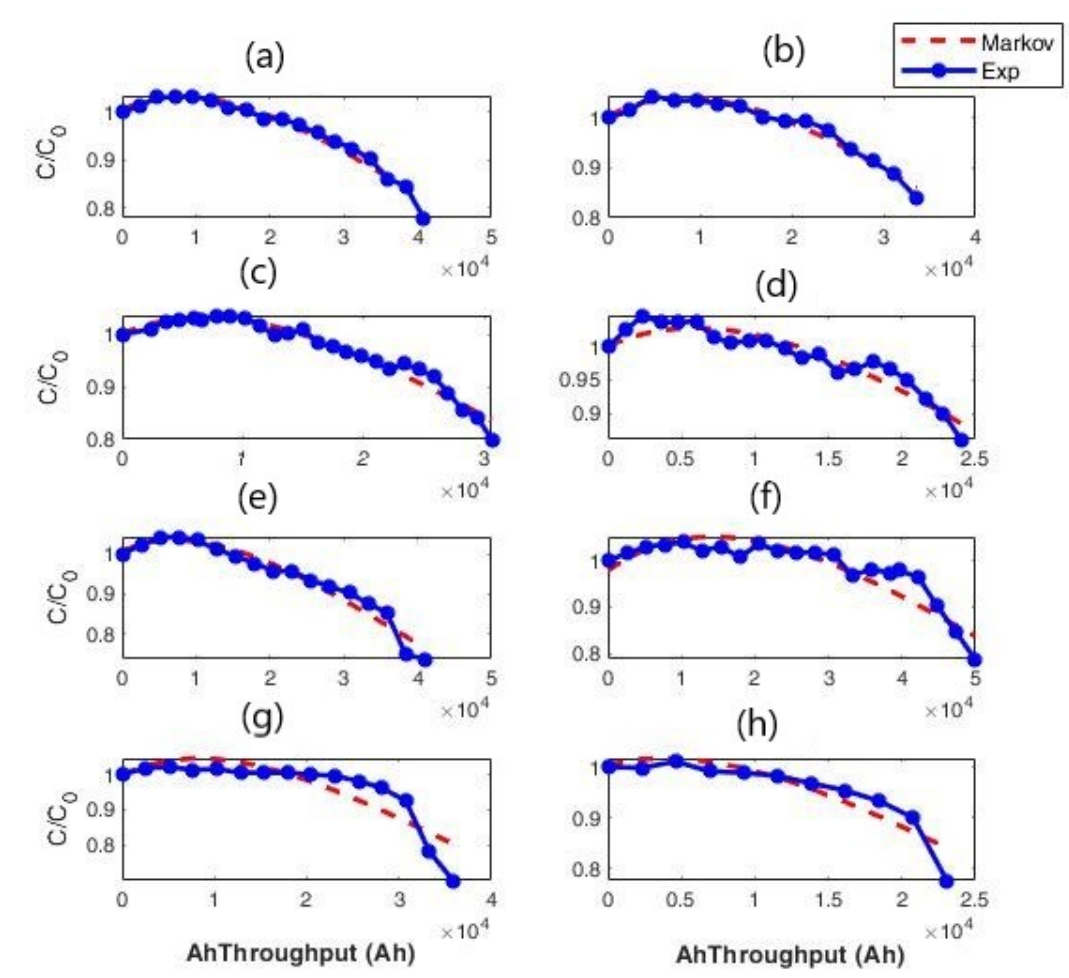
Figure 5. Comparison between the trend of the experimental and Markov degradation curve for cells 1–8. Blue line, diamond symbol: experimental data and red line square symbol: Markov fitting: ( a ) battery number 1; ( b ) battery number 2; ( c ) battery number 3; ( d ) battery number 4; ( e ) battery number 5; ( f ) battery number 6; ( g ) battery number 7; ( h ) battery number 8.